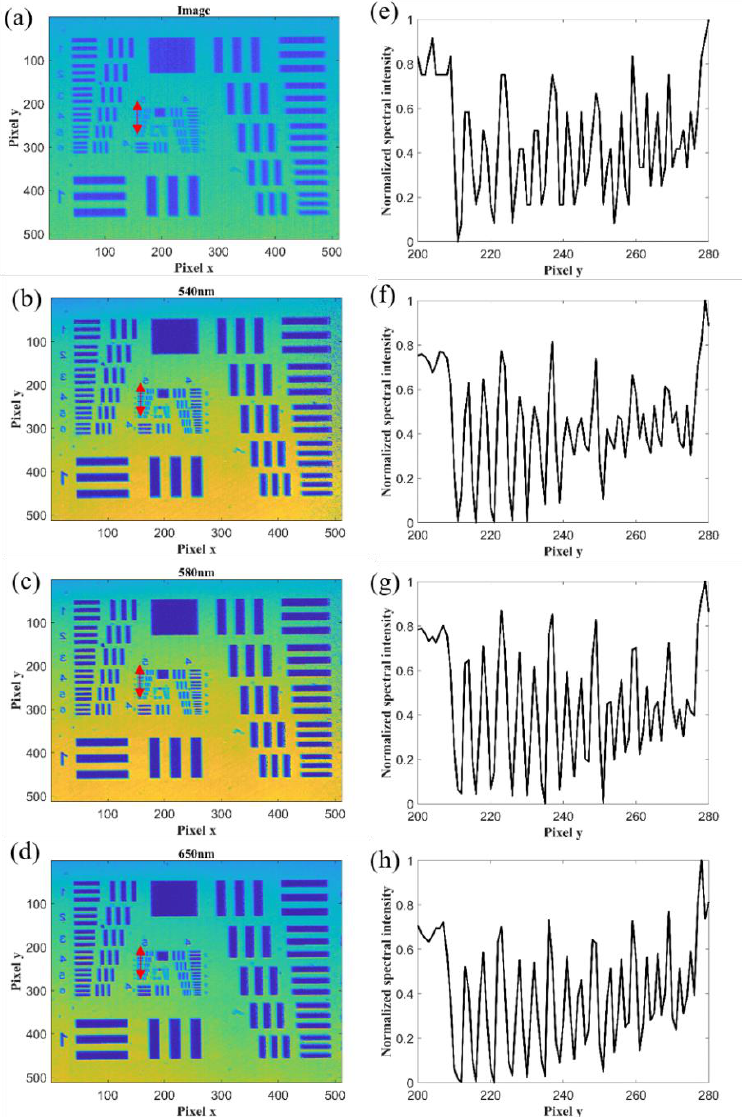
Figure 9. ( a ) Integration of the two-dimensional spatial information acquired for the whole spectrum. ( b – d ) The two-dimensional spatial information at 540 nm, 580 nm, and 650 nm. ( e – h ) correspond to ( a – d ) for the intensity information at each point for x = 158 and y values from 200 to 280. Considering the size of the damage point, K9 glass was utilized for the damage anal- ysis of the sample. From Figure 10b, the spectra of the damaged and undamaged points can be obtained. Figure 10c,d indicate the one-dimensional intensity information acquired at x = 203 for the whole spectrum and at 580 nm. In Figure 10c, the minimum size of the damage point detected is 16 µm, while the minimum size of the damage point is 12 µm in